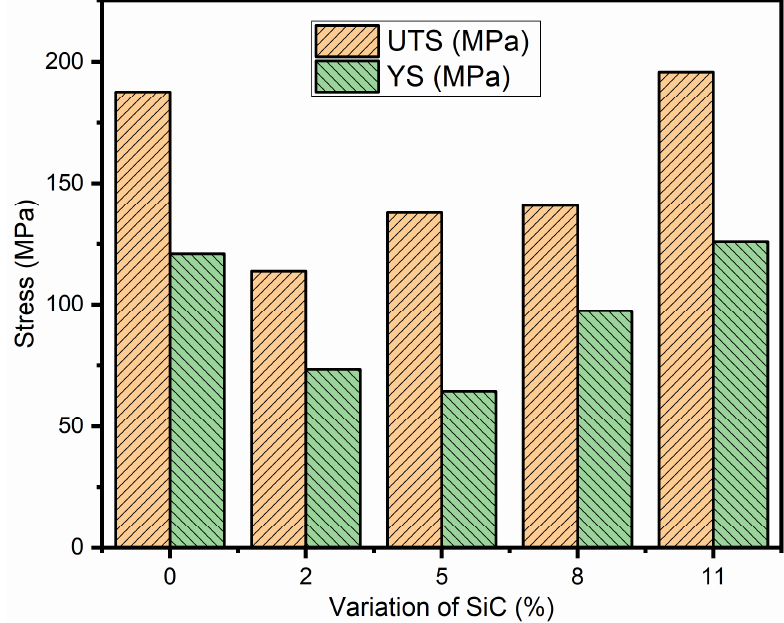
Figure 6. Variation of ultimate tensile strength and yield strength with the variation of SiC particulates.